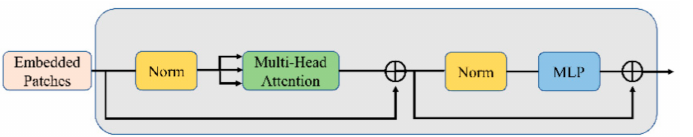
Figure 2. The structure of the transformer